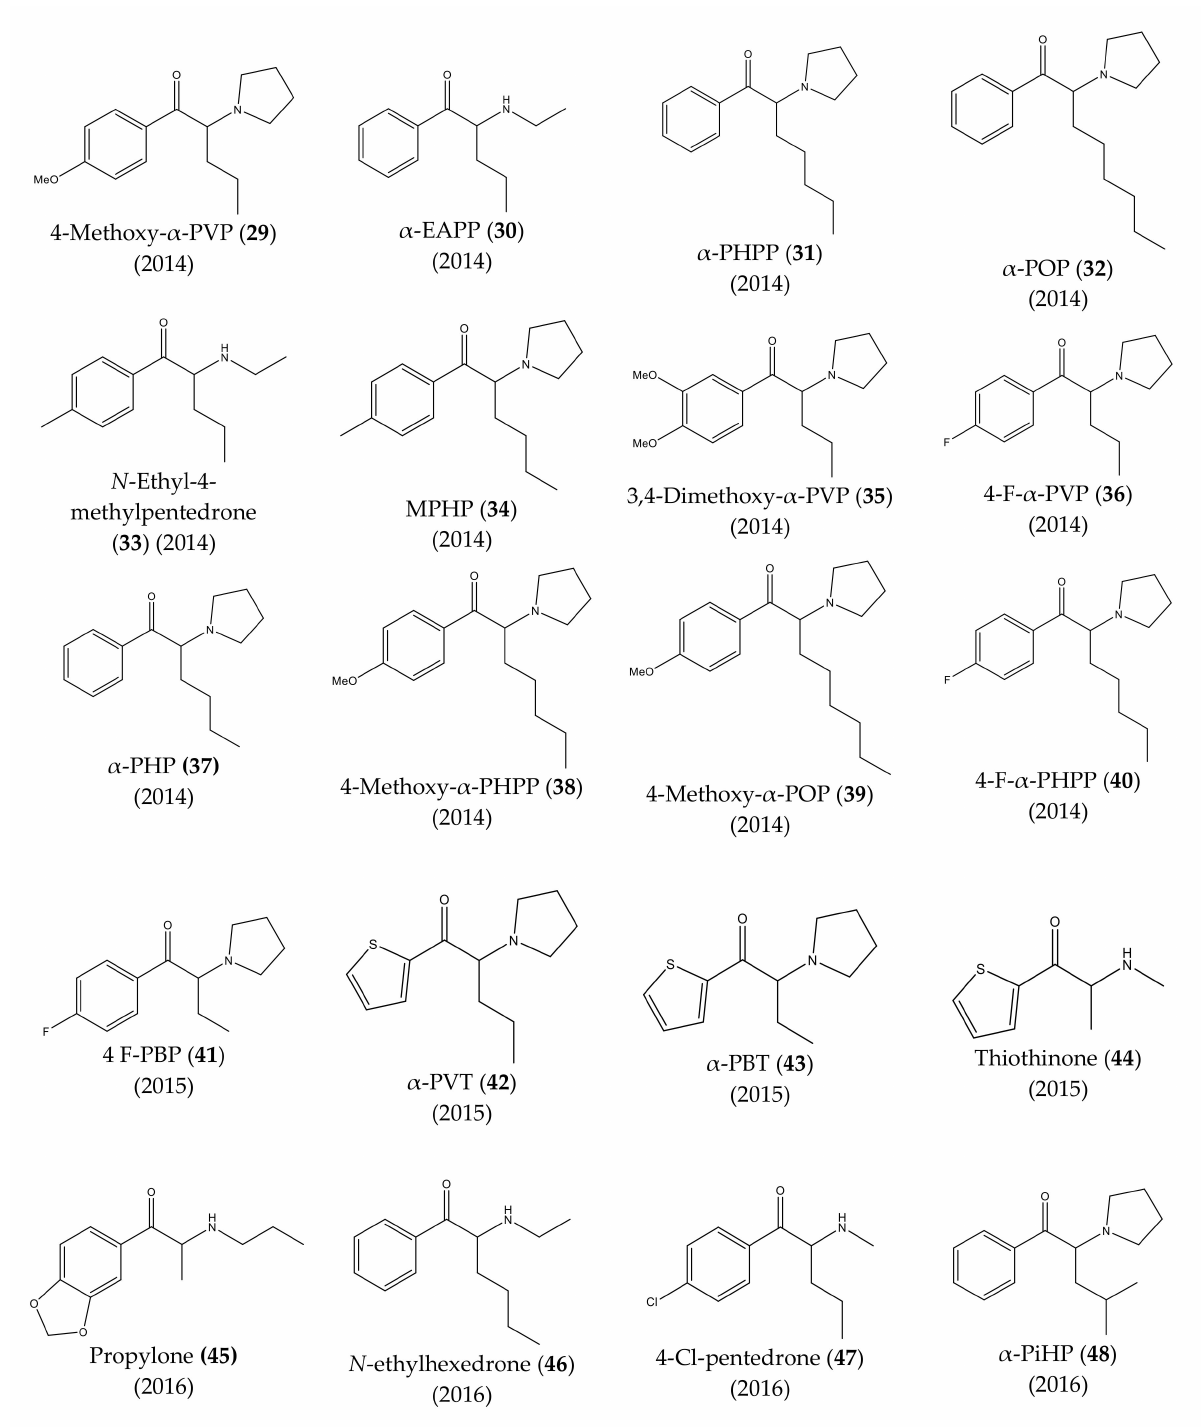
Figure 7. Structures of the most recent cathinone derivatives ( 29 )–( 48